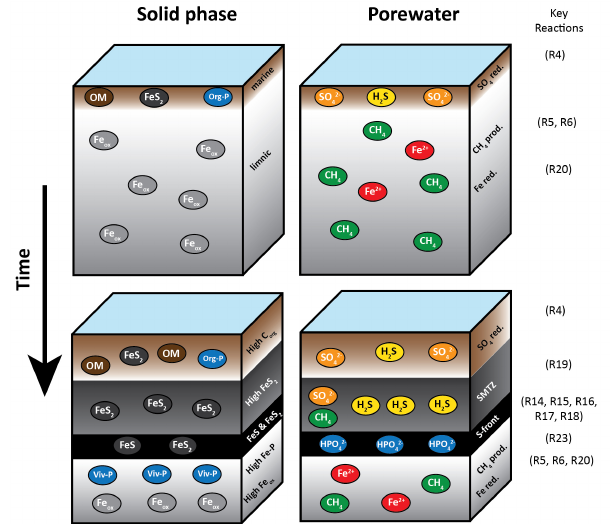
Figure 9. Schematic of the main diagenetic processes discussed in this study and their imprint on the geochemical solid-phase (left) and porewater profiles (right). Accumulation of marine sediments with time and the subsequent downward diffusion of SO 2 − into 4 the CH 4 -bearing limnic sediment stimulate SO 4 -AOM around the sulfate-methane transition zone (SMTZ), thus enhancing the down- ward sulfidization of the Fe-oxide-rich lake deposits. Below the sul- fidization front (S front), HPO 2 − released during reductive dissolu- 4 tion of Fe oxides is bound again in vivianite, leading to an enrich- ment in sedimentary P in these sediments. Numbers on the right indicate the key reactions occurring in the corresponding sediment layers as described in Table 3. Note that in this study, Fe-AOM (R20) was assumed as the main source of porewater Fe 2 + below the S front to further test the potential impact of Fe-AOM on pore- water CH 4 . However, based on the geochemical data, we cannot exclude a potential role for organoclastic Fe reduction (R3) and/or reactivation of less reactive Fe oxides by